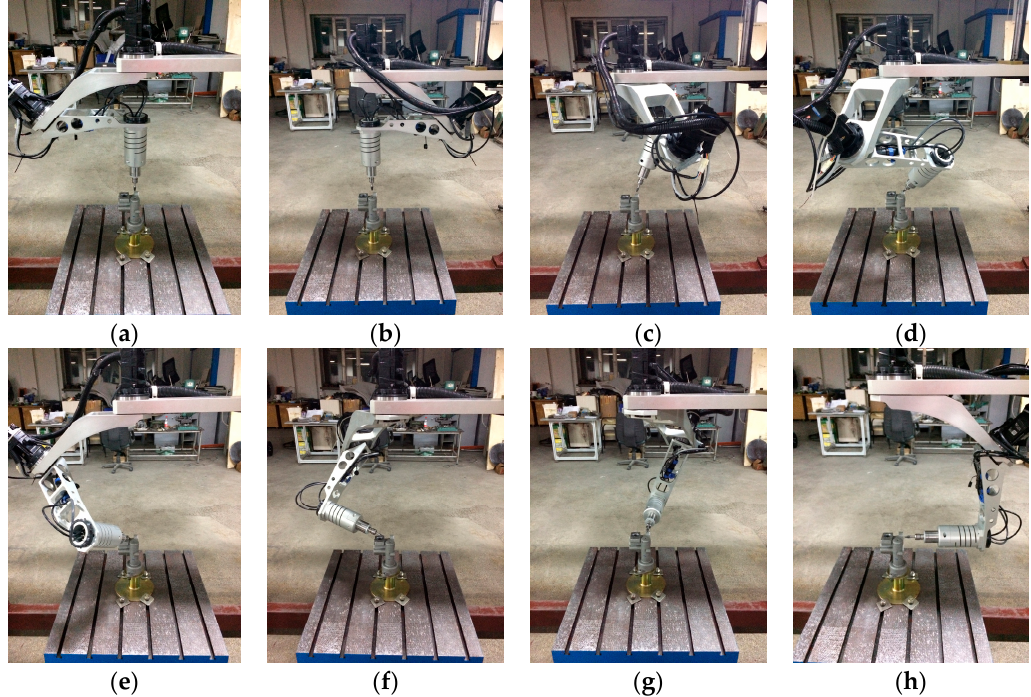
Figure 9. Experimental validation of the dexterous manipulation (unit is radian): ( a ) ϕ 4 = 0, ϕ 5 = 0; ( b ) ϕ 4 = − π ; ϕ 5 = 0; ( c ) ϕ 4 = − 2 π /3; ϕ 5 = π /6; ( d ) ϕ 4 = − π /6; ϕ 5 = π /3; ( e ) ϕ 4 = 0; ϕ 5 = π /2; ( f ) ϕ 4 = π /6; ϕ 5 = 2 π /3; ( g ) ϕ 4 = 2 π /3; ϕ 5 = 5 π /6; ( h ) ϕ 4 = π ; ϕ 5 = π